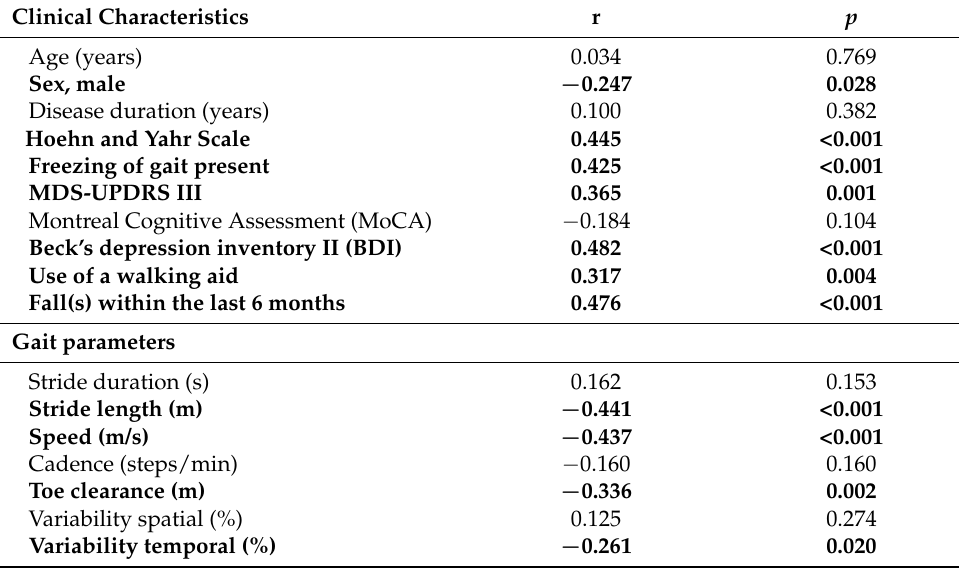
Table 3. Spearman correlation with fear of falling (FES-I).